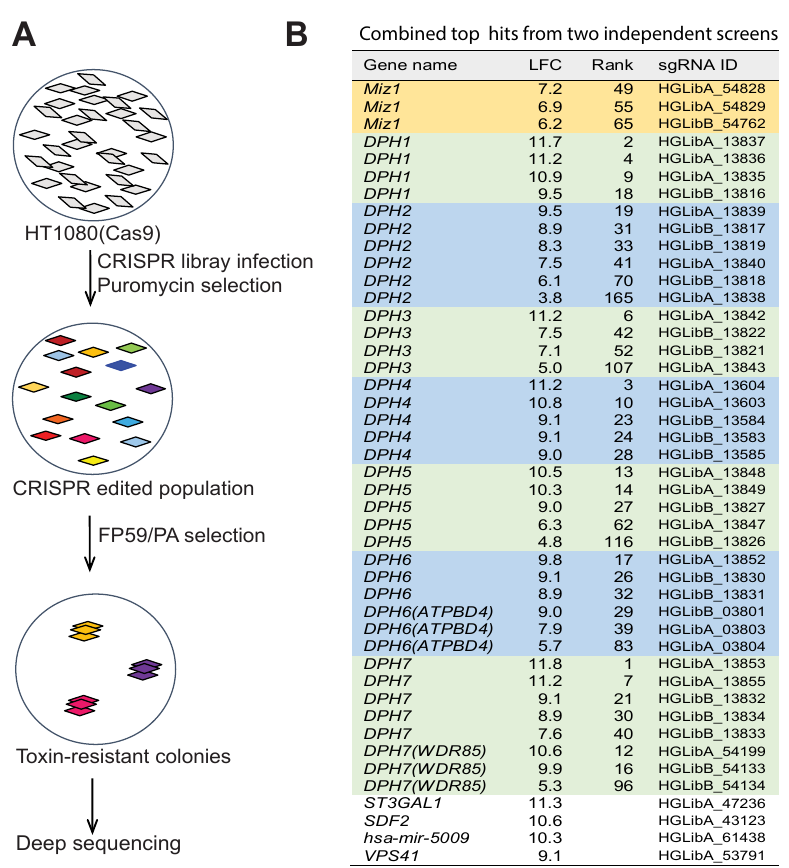
Fig 1. Whole genome CRISPR knockout screens to identify host factors required for the action of PA/FP59. A . A workflow of the whole genome CRISPR knockout screen. 6 × 10 7 HT1080 (Cas9 expressing) cells were infected with the human lentiviral CRISPR library A or B (M.O.I. = 0.3). The CRISPR gene-edited cells were selected by puromycin (5 μ g/ml) for 10 days. Then, the cells were treated with PA/FP59 (100 ng/ml each, about 10-fold of the minimum lethal concentration) twice with a two-day interval between treatments, and the toxin-resistant cells were allowed to form colonies by further culturing. The surviving, toxin-resistant cells were pooled, DNA extracted, and the sgRNA- containing fragments amplified and analyzed by Illumina deep sequencing for sgRNAs. B . Top hits from both library- A and library-B by Illumina deep sequencing. Only the genes with Log2(fold change) (LFC) � 3 and were hit by � 2 sgRNAs were considered as true positives and listed, along with the top four potential hits with just a single sgRNAs. Please refer to the S1 Data and S2 Data for details. frequency � 2 sgRNAs even after combining the results from both screens (S1 Data, S2 Data, and Fig 1B). Other hits having only a single sgRNA are likely to be false positives, perhaps resulting from co-infection (being passengers) with one of the biologically active hits. To verify this and confirm the essential role of Miz1 in the toxin action, we regenerated the Miz1 -, Dph1 - (as a positive control), as well as the top four hits by single sgRNAs– ST3GAL1 -, SDF2 -, hsa-mir-5009-, and VPS41 -gene edited HT1080 cells (Fig 1B) by CRISPR editing. We exam- ined the toxin sensitivity of 20–30 clones of each of these CRISPR edited cells, and found that only Miz1- and Dph1-KO cells were resistant to PA/FP59 (S1 Table). Miz1 is required for diphthamide biosynthesis To test whether Miz1 is generally required for the action of ADP-ribosylating toxins, we gener- ated a Miz1-KO cell line from the mouse macrophage RAW264.7 cell line, as well as a